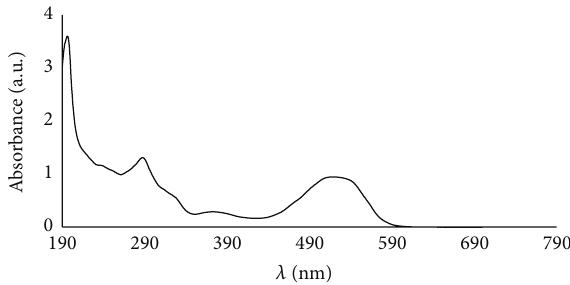
Figure 2: Spectrum of UV-VIS absorption of the sulfonated azo dye Reactive Red 198